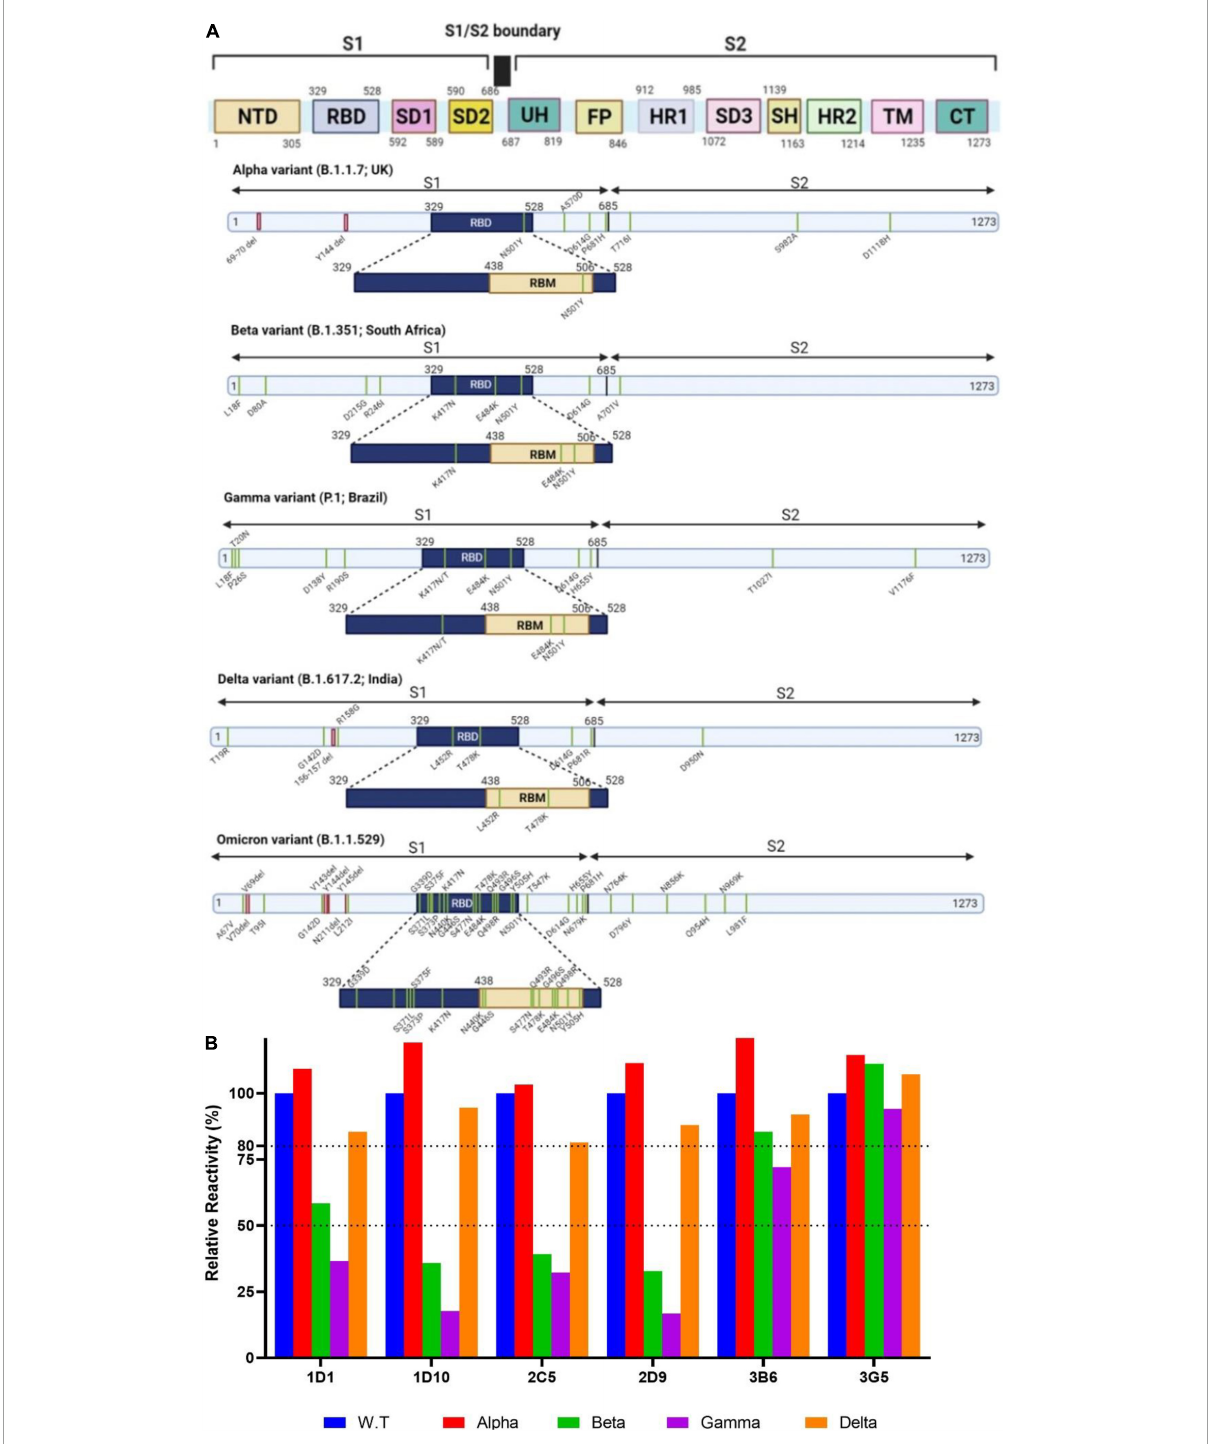
FIGURE6 Schematic overview of the spike proteins from the SARS-CoV-2 VOCs and binding activity of MAbs against VOCs. (A) The primary structure of the spike protein and the location of the mutations in the context of the spike protein are shown in distinct panels. (B) Relative binding reactivity of selected MAbs was measured against the trimeric spike of SARS-CoV-2 alpha (red), beta (green), gamma (purple), and delta (brown) variants compared with that of wild-type (blue) by ELISA. ELISA, enzyme-linked immunosorbent assay; FP, fusion peptide; HR, heptad repeat; MAb, monoclonal antibody; NTD, N-terminal domain; RBD, receptor binding domain; RBM, receptor-binding motif; S, spike; SARS-CoV-2, severe acute respiratory syndrome coronavirus 2; SD, subdomain; SH, stem helix; TM, transmembrane; UH, upstream helix; VOC, variant of